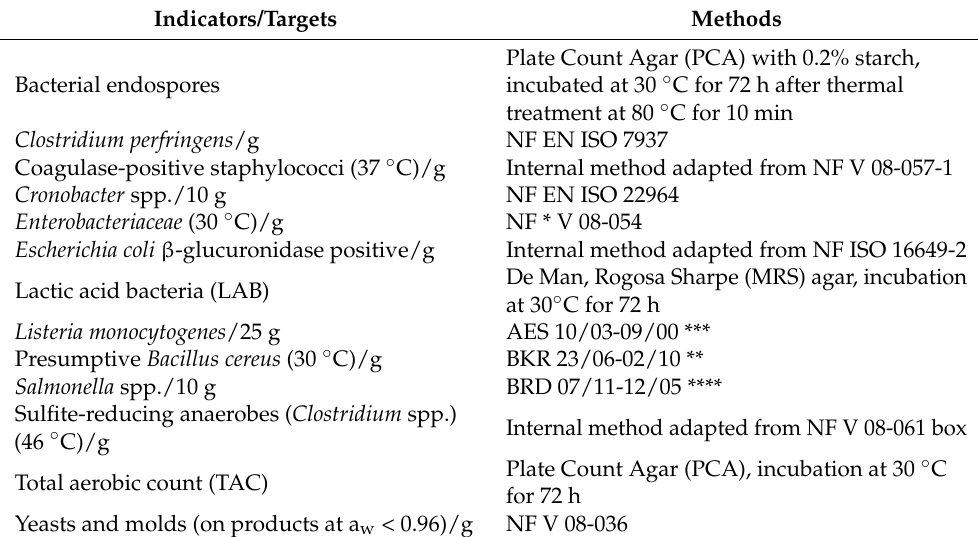
Table 2. Microbiological analysis methods. Indicators/Targets